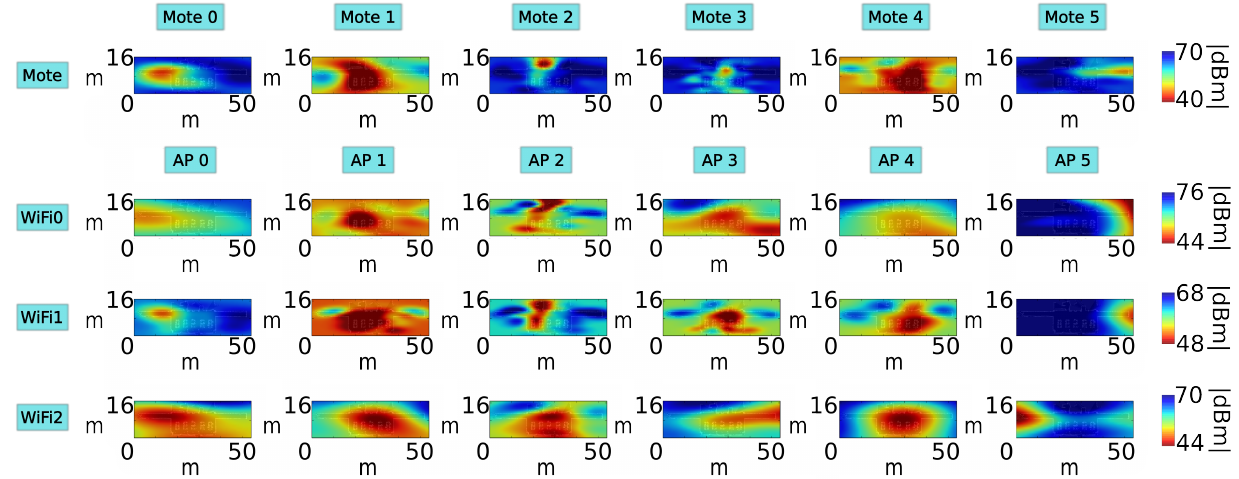
Figure 8. Radio maps generated with one of the datasets. Each row represents a different receiver (mote or WiFi card) and each column a different transmitter (mote or WiFi